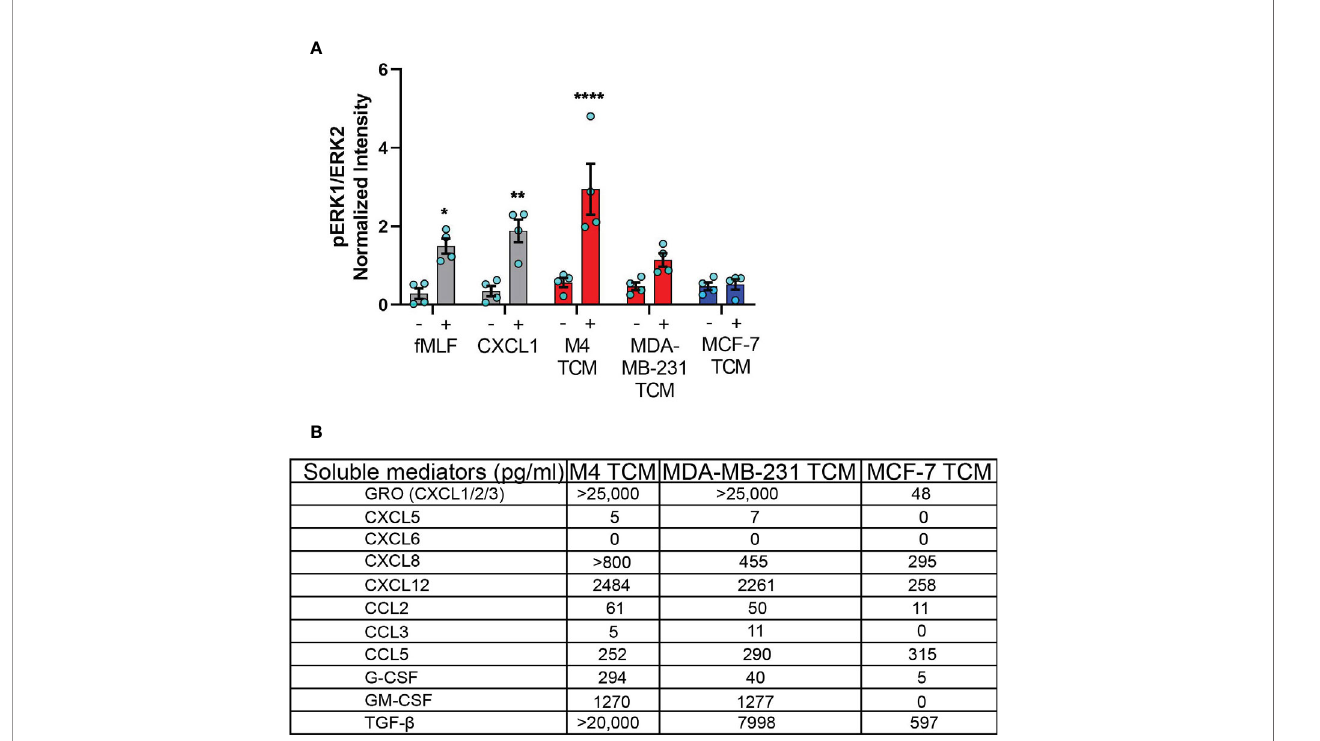
FIGURE 6 | TNBC cell lines secrete neutrophil activating factors more abundantly than ER+ cancer cell lines. (A) Graph depicting pERK1/ERK2 intensity in neutrophils stimulated with controls (fMLF, CXCL1, media) or equal volume of TCM derived from M4, MDA-MB-231, or MCF-7 cells. The quanti fi ed pERK1/2 band intensity was normalized to a -tubulin and is shown as mean ± SEM from N=4 individual donors represented by each dot. ****P < 0.0001, **P ≤ 0.01, *P ≤ 0.05 when compared with corresponding vehicle controls (two-way ANOVA with Sidak multiple comparisons test). (B) Table showing the amount (pg/ml) of chemokines, growth factors and cytokines secreted by M4, MDA-MB-231 and MCF-7 cells determined by multiplex ELISA